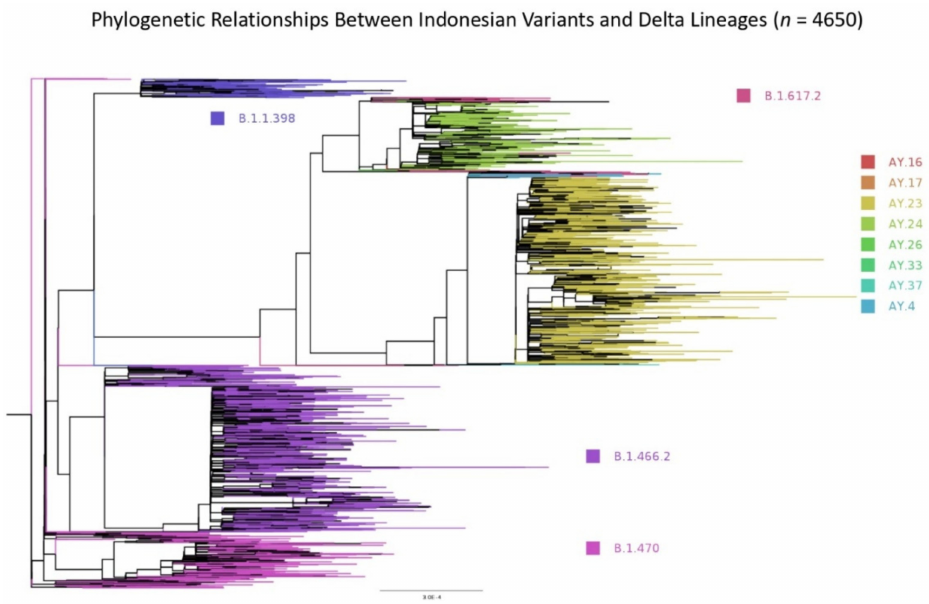
Figure 5. Phylogenetic relationships between the Indonesian variants (B.1.466.2, B.1.470, and B.1.398) and all Delta lineages per 1 October 2021 ( n = 4650). The scale of branch length is